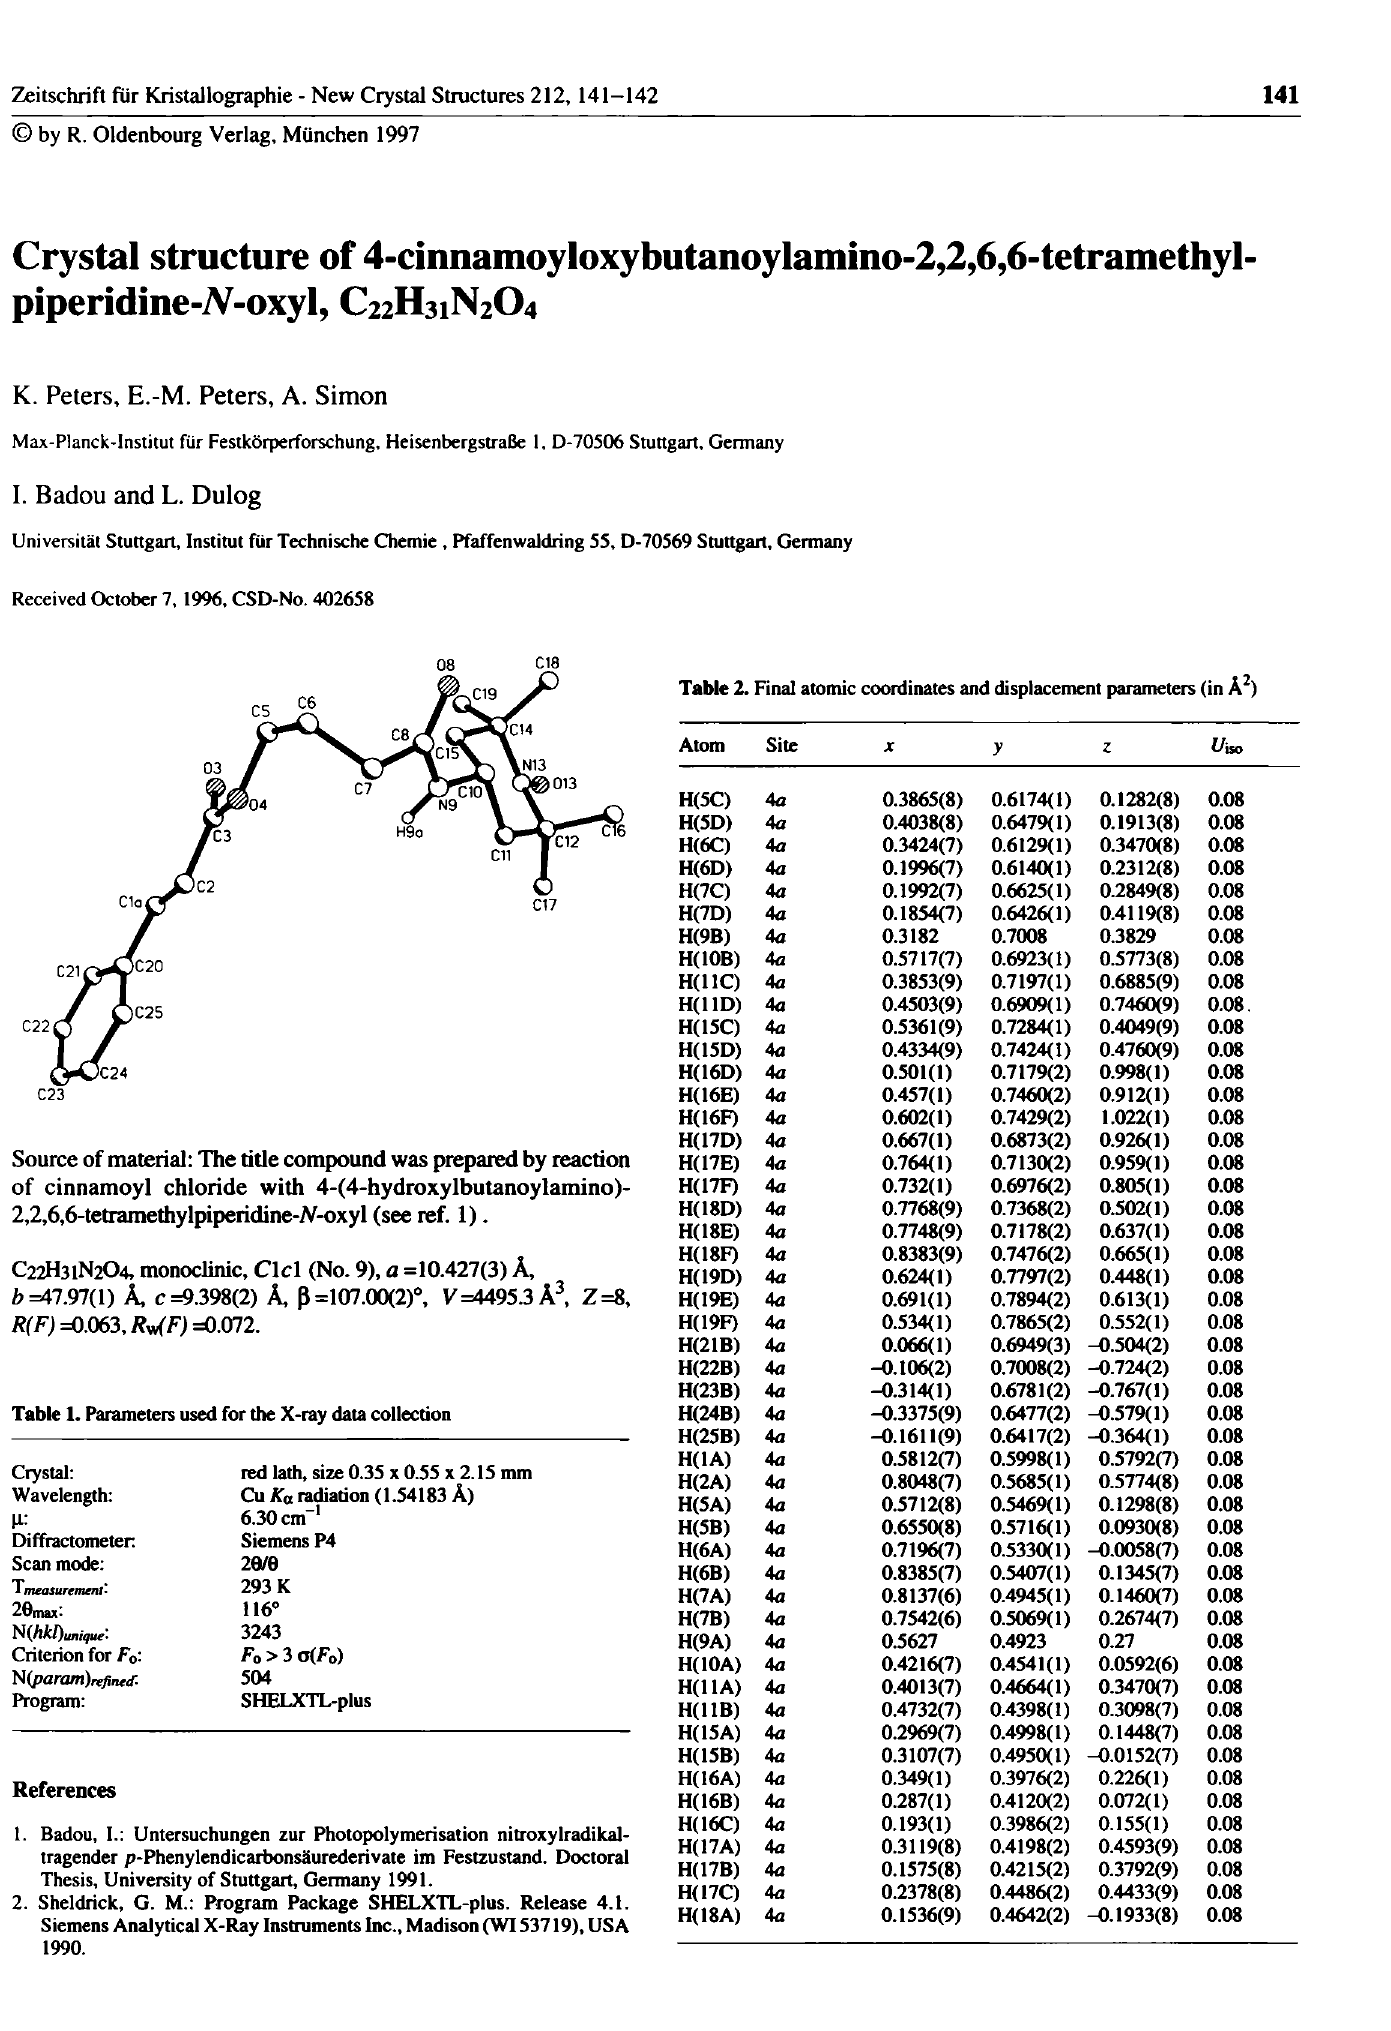
Table 1. Parameters used for the X-ray data collection